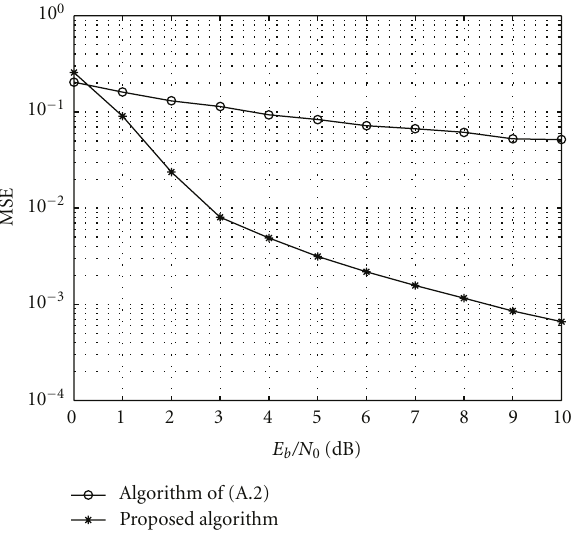
Figure 5: MSE of the phase o ff set estimation when no CFO is present in the system-BPSK modulation.